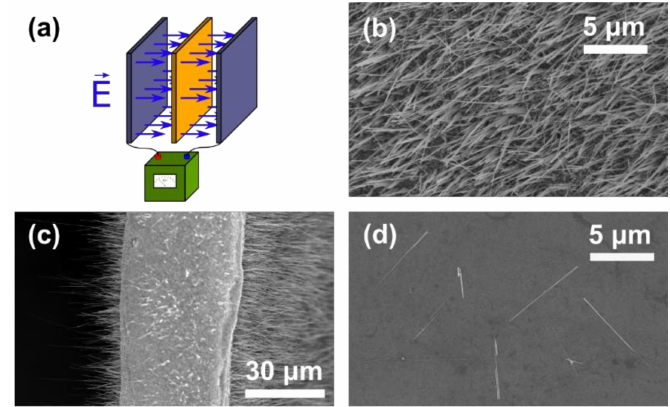
Figure 1. ( a ) Schematic representation of Cu foil between electrodes; SEM images: ( b ) CuO nanowires synthesized on a Cu foil (top view); ( c ) CuO nanowires synthesized on a Cu foil (side view); ( d ) transferred CuO nanowires on Si / SiO 2 substrate.